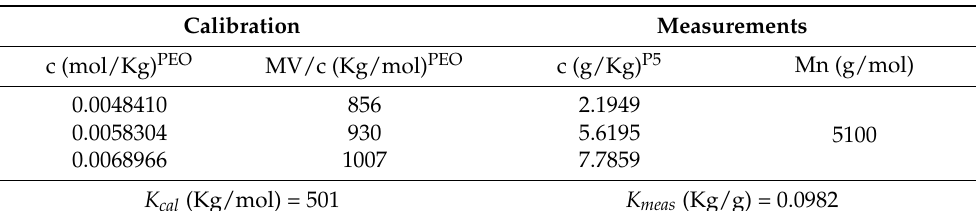
Table 2. Data of calibration, results of measurements and estimation of Mn of P5 according to Equation